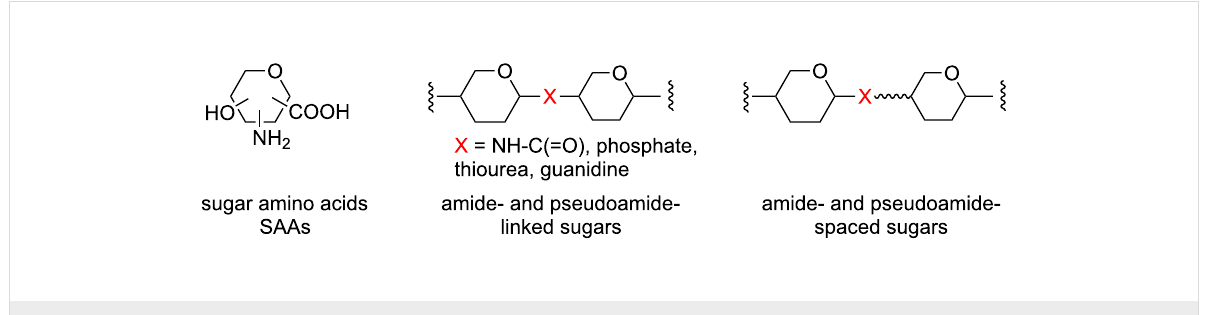
Figure 1: Schematic representation of sugar aminoacids (SAAs) and (pseudo)amide oligosaccharide mimetics.